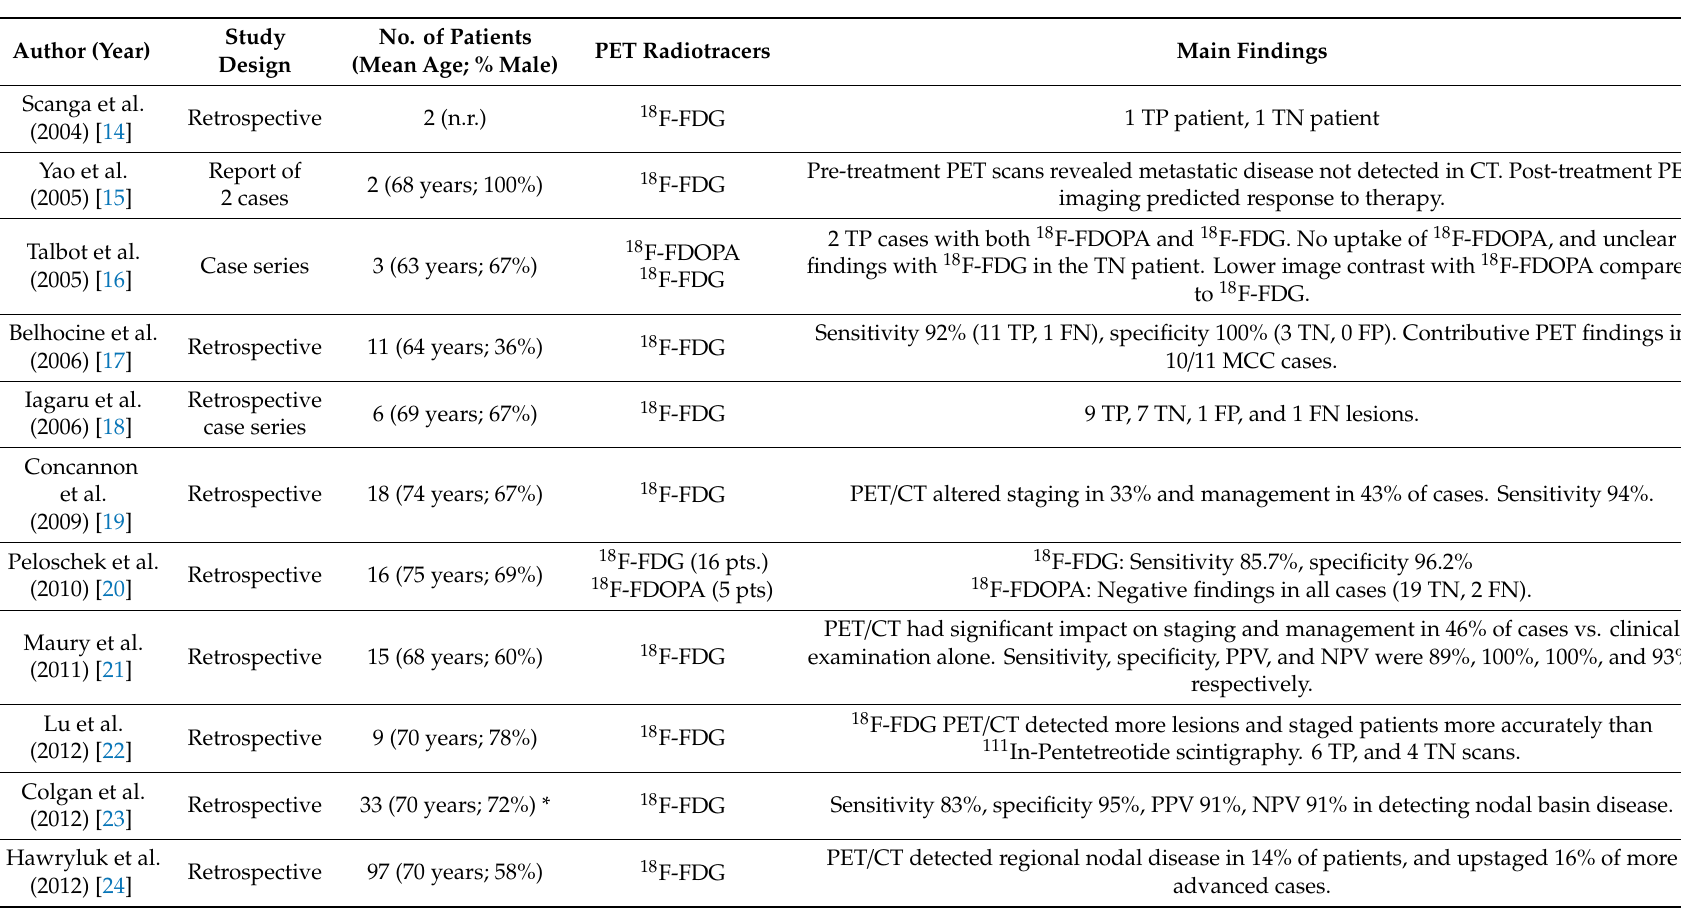
Table 1. Summary of the published studies (including > 1 patient) on positron emission tomography (PET) in Merkel cell carcinoma (in chronological order).